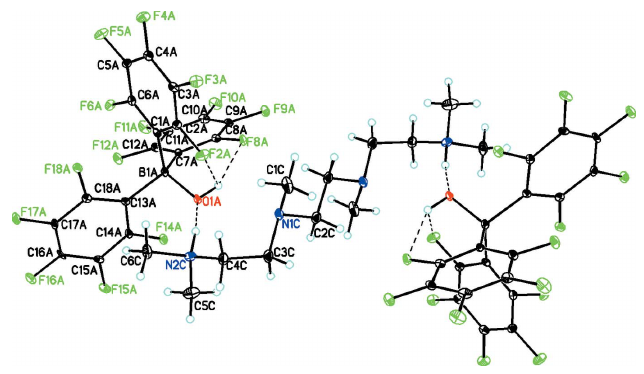
Figure 1 Diagram showing the structure of the [C 12 H 32 N 4 ] 2+ dication ( C ) and two [C 18 HBF 15 O] + anions ( A ). Only symmetry-independent atoms are labelled. Benzene solvate molecules are omitted for clarity. Hydrogen bonds are shown with dashed lines. Atomic displacement parameters are at the 30% probability